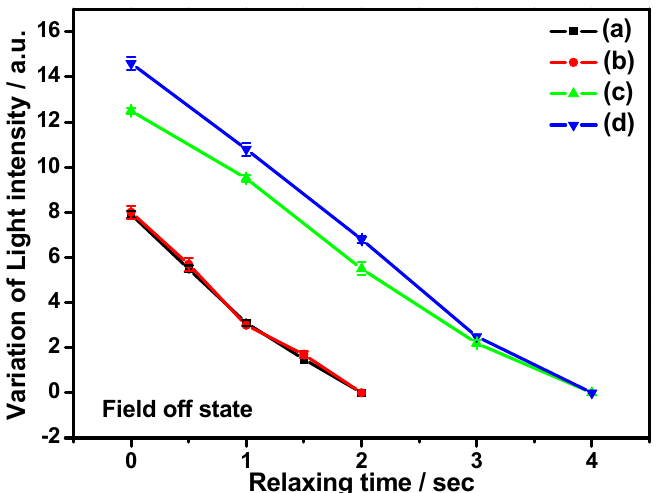
Figure 3. The measured relaxation-induced light intensity variation of representative GP flakes according to Figure 1. The field off state for Case I is 0 s, 0.5 s, 1 s, 1.5 s, and 2 s, and for Case II is 0 s, 1.0 s, 2.0 s, 3.0 s, and 4.0 s, respectively (Case I: flake area and aspect ratio in ( a , b ): 35 µ m 2 with an aspect ratio of 2:1 and 85 µ m 2 with an aspect ratio of 1:1; Case II: flake area and aspect ratio in ( c , d ): 37 µ m 2 with an aspect ratio of 2:1 and 90 µ m 2 with an aspect ratio of 1:1). The scattered points represent the experimental data along with measurement error bars, and the lines are guides for the eye. Error bars for respective data points are assigned considering standard deviations obtained in repetitive observations.